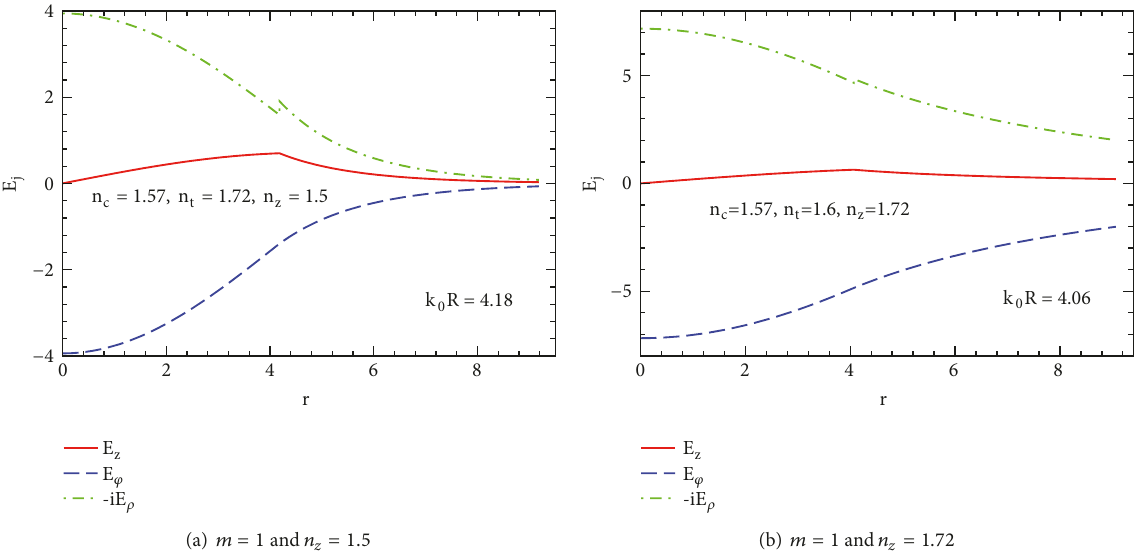
Figure 6: Components of electromagnetic field as a function of the dimensionless radial parameter 𝑟 = 𝑘 0 𝜌 for the mode with 𝑚 = 1 at (a) 𝑛 = 1.5 and (b) 𝑛 = 1.72 𝑧 𝑧